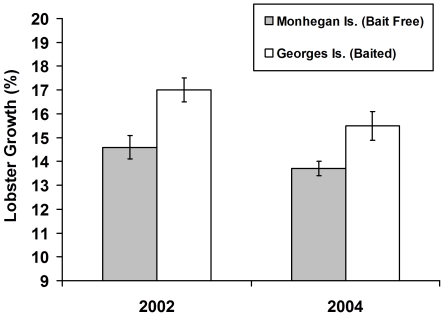
Contribution of herring to the diet of lobsters in mid-coast Maine.(a) Fractionation coefficients were calculated by subtracting the isotopic values of lobster prey from the value of MI lobsters from October that have not consumed herring recently. (b) Isotope values for lobsters that feed only on herring were calculated by adding the fractionation coefficient calculated above for lobsters to herring isotope values. Isotope values of lobsters that recently had access to herring bait (MI June samples) were then compared to the estimated isotopic value of lobsters that feed 100% on herring vs. completely on natural prey (MI October samples) to determine the proportion of herring in the diet of lobsters in mid-coast Maine when fishing is permitted. Error bars denote +1 SE.